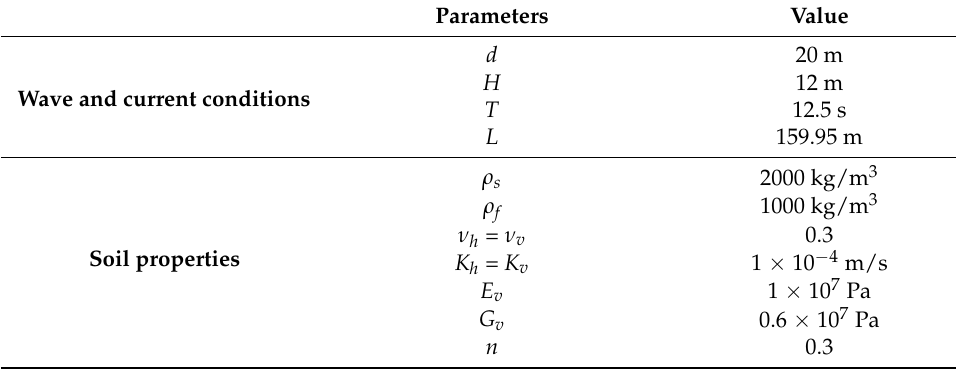
Table 6. Wave conditions and TIP soil properties by Jeng